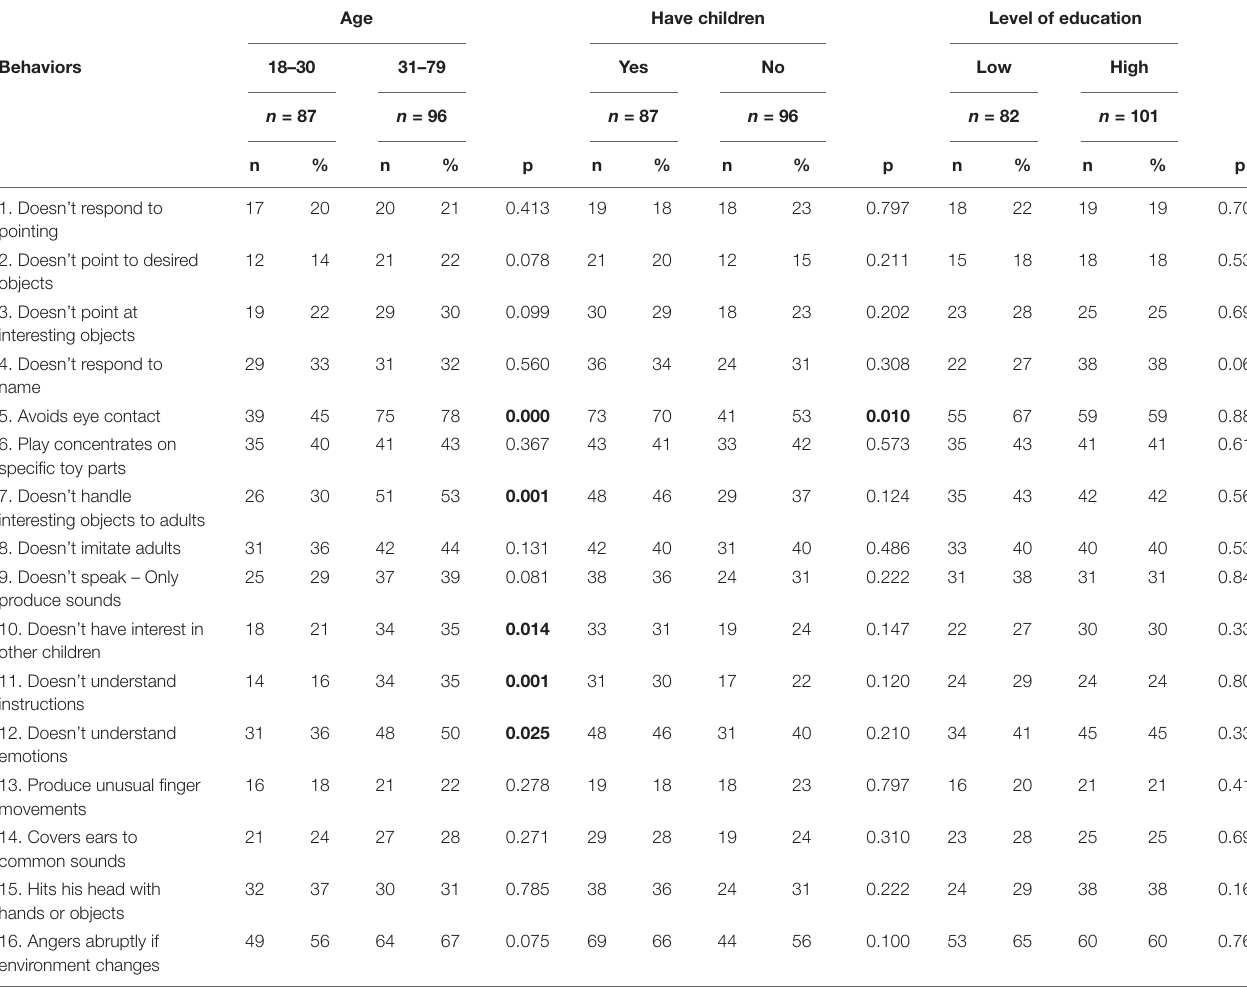
TABLE 4 | Differences of proportions of participants that identified the 16 behaviors as “concerning” as a function of age, parenthood, and level of education. Age Have children Level of